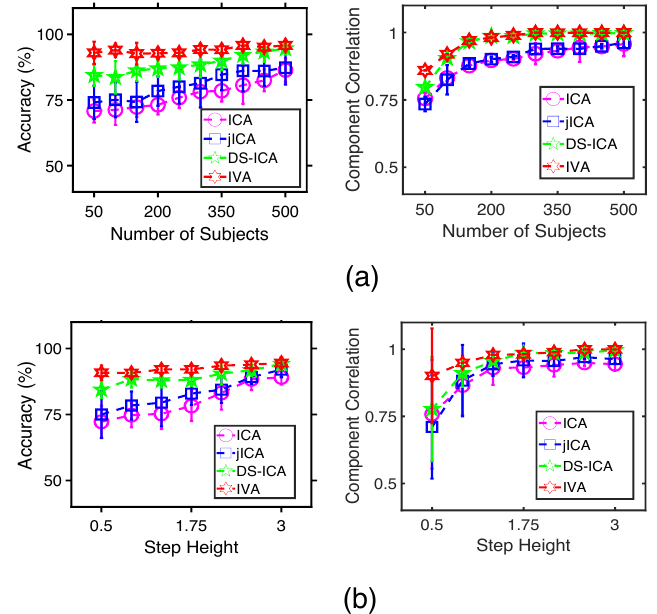
Figure 4. Estimation performance of individual ICAs, jICA, DS-ICA, and IVA for different ( a ) number of subject and ( b ) Step-heights. Here, correlated profiles and behavioral features are identified using the one-to-one correlation analysis technique. All the results are averaged over 100 independent runs.